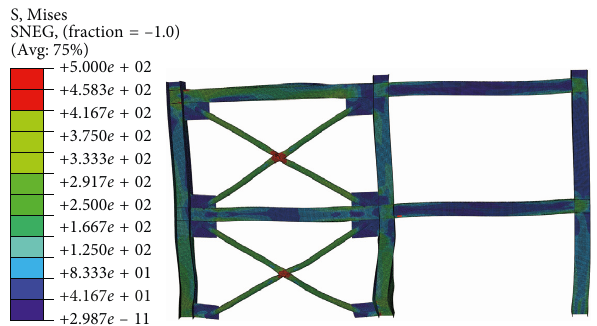
Figure 14: Stress program of the